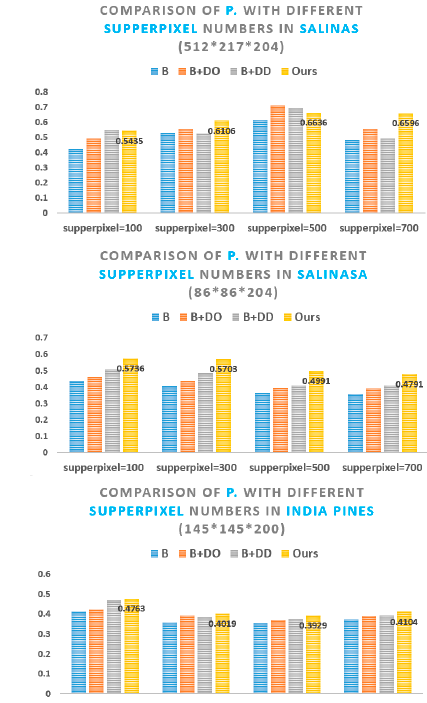
Figure 4. Classification results in different sampling interval.